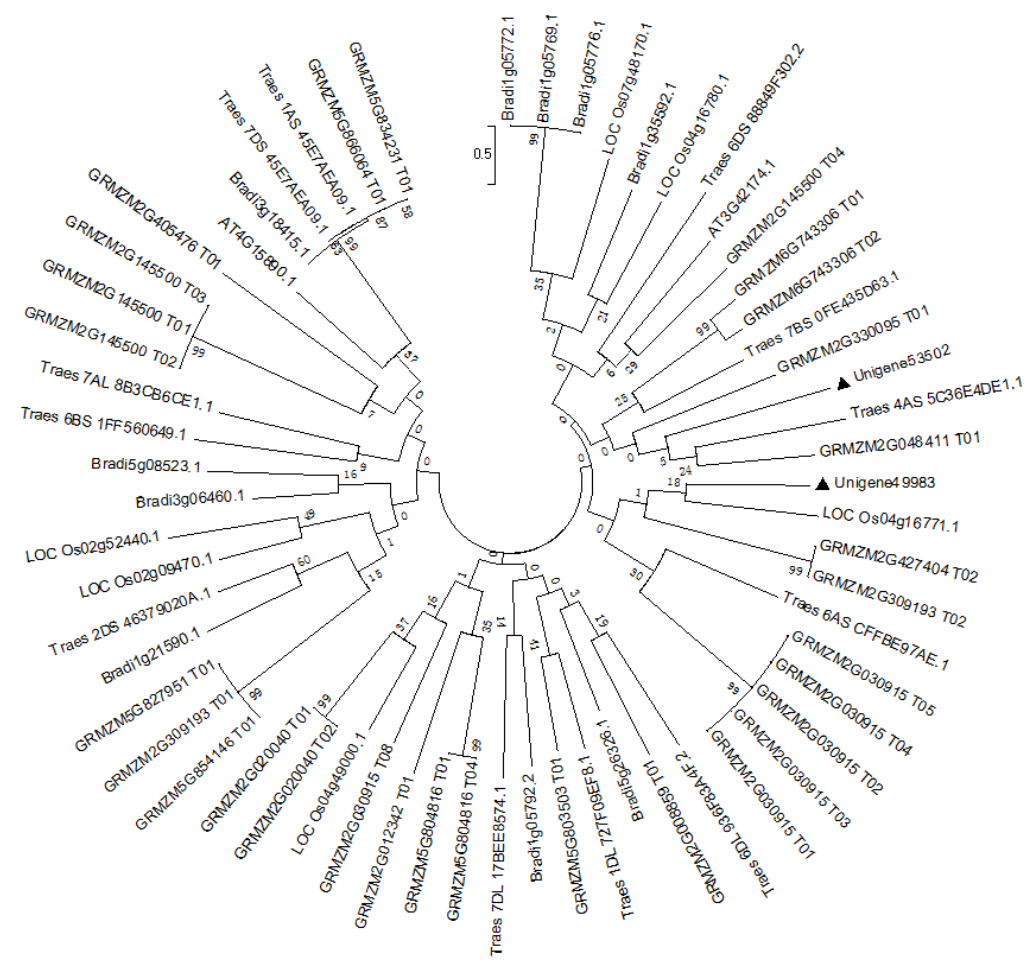
Figure 6. Phylogenetic analysis of 6 miRNAs’ target genes in A. mongolicum.